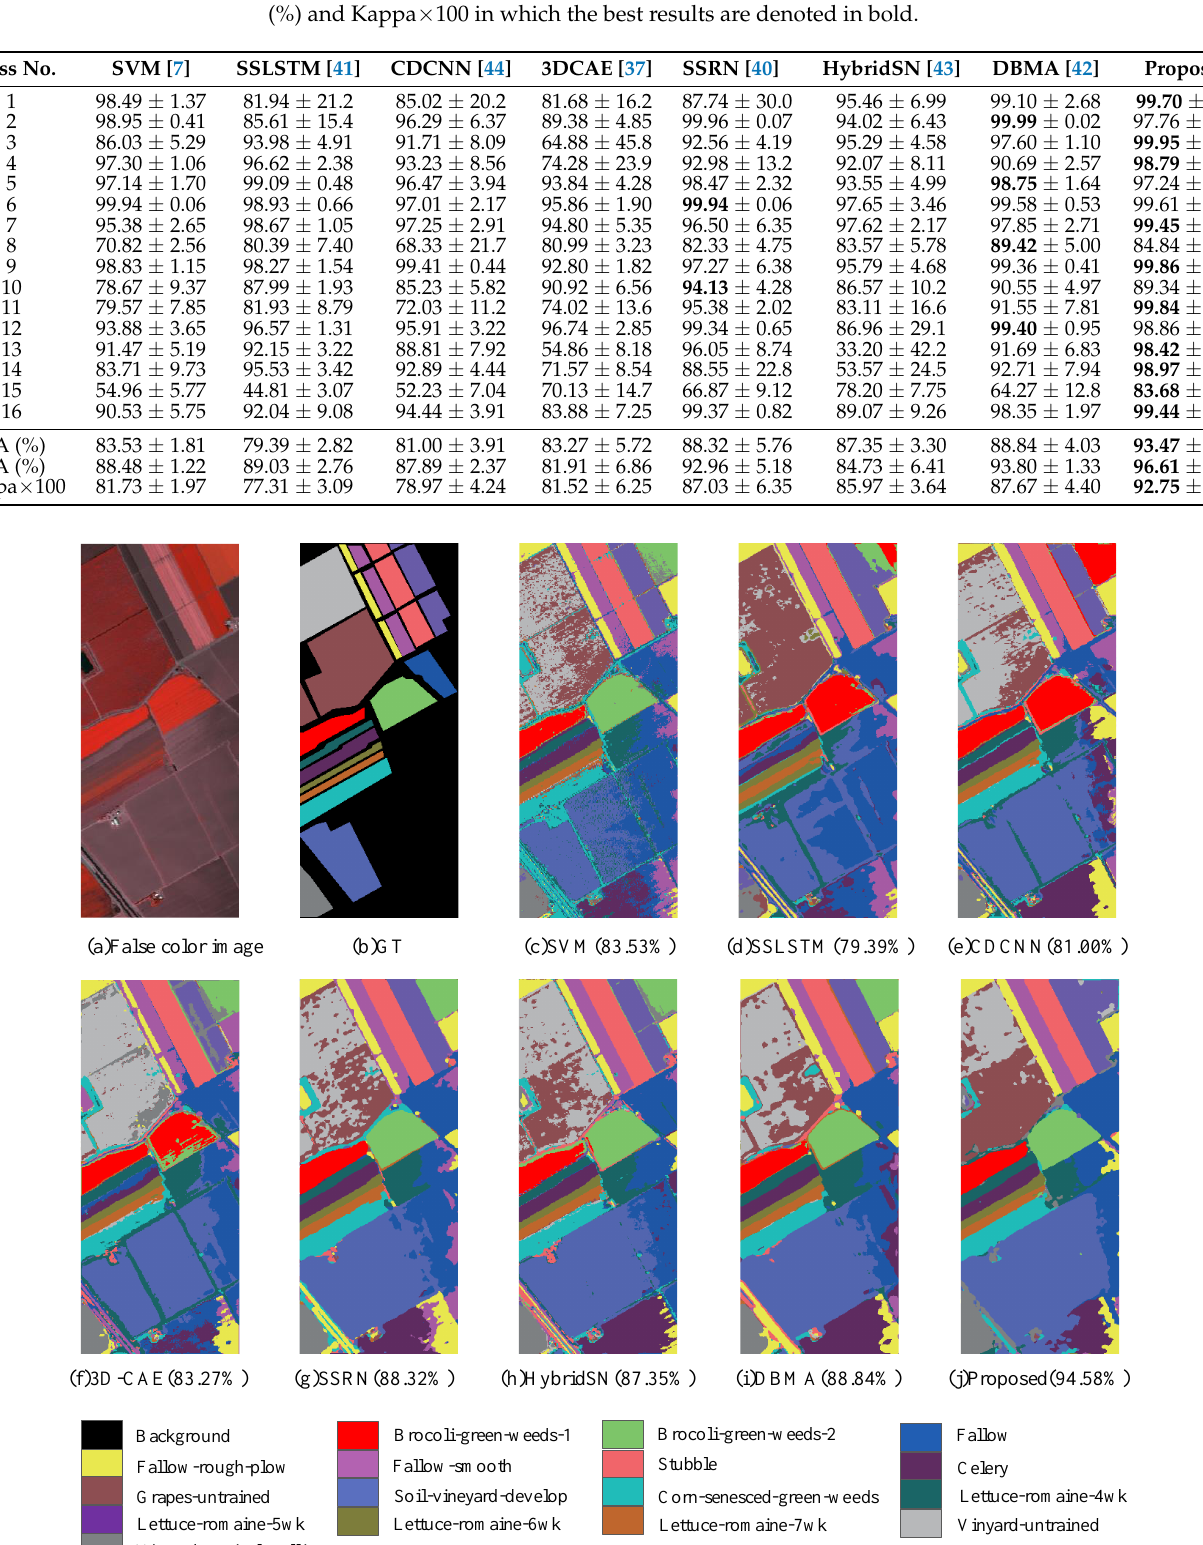
Figure 6. The classification maps of the Salinas with 10 labeled